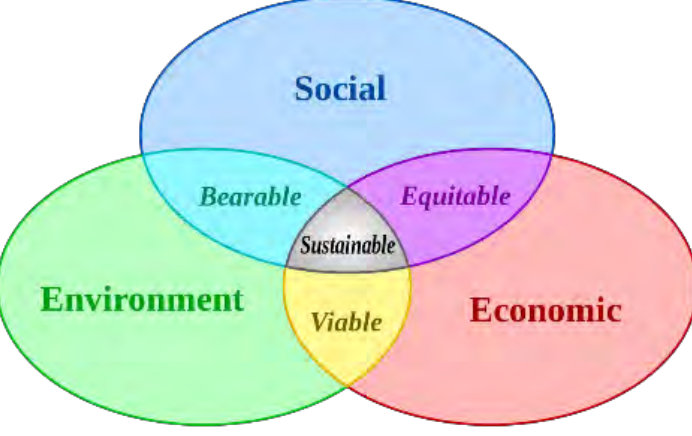
Figure 1. Sustainability